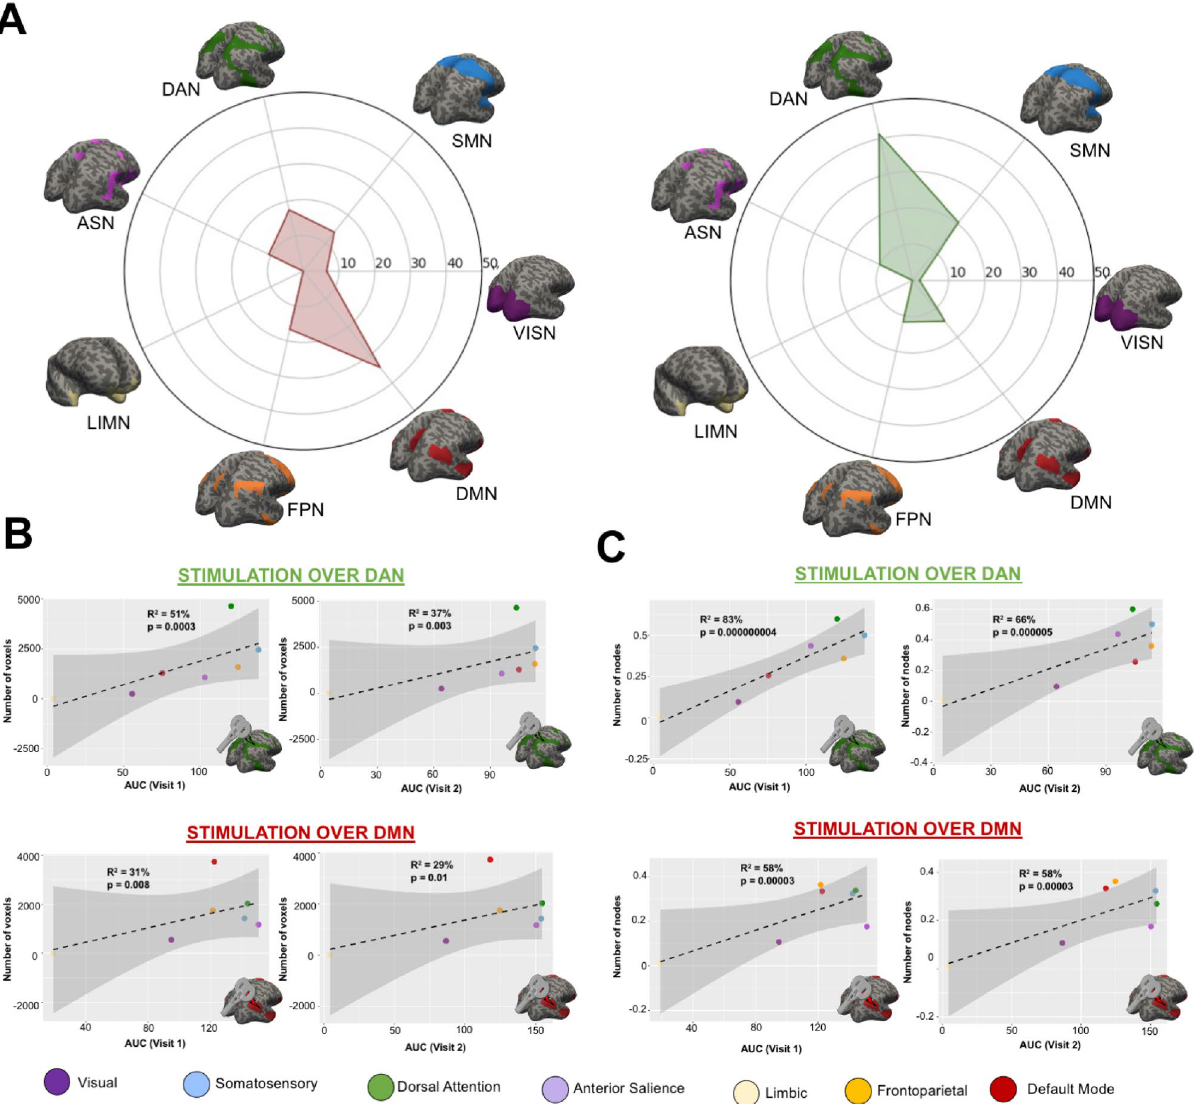
Figure 4. Relationship between source TMS-EEG signal and DWI pathway projection. ( A ) Percentage of grey matter voxels (divided by network) reached by seed-based tractography from the stimulation spot. As for angular gyrus (DMN stimulation seed), the white matter fibers not only reach cortical regions belonging to the DMN (34.52%) but also affect the other RSNs (VISN = 6.52%; SMN = 13.95%; DAN = 17.55%; ASN = 10.72%; LIMN = 0.04%; FPN = 16.71%). Likewise for the superior parietal lobule (DAN stimulation spot), the seed-based tractography do not involve grey matter voxels belonging to DAN (41.38%), but also reach the other RSNs (VISN = 2.00%; SMN = 20.42%; ASN = 9.98%; LIMN = 0.01%; FPN = 11.77%; DMN = 14.45%). ( B ) A significant positive correlation was found between the number of voxels reached by the seed-based tractography (divided by network) and the AUC extracted for both DAN (visit 1: R 2 = 51%, p = 0.0003; visit 2: R 2 = 37%, p = 0.003) and DMN (visit 1: R 2 = 31%, p = 0.008; visit 2: R 2 = 29%, p = 0.01). ( C ) A significant positive correlation was found between the number of networks nodes (normalized for the overall number of network nodes) reached by the seed-based tractography and the AUC extracted for both DAN (visit 1: R 2 = 82%, p = 0.000000004; visit 2: R 2 = 66%, p = 0.000005) and DMN (visit 1: R 2 = 58%, p = 0.00003; visit 2: R 2 = 58%, p = 0.00003). Scatterplots were generated using R software (https:// www.R- proje ct. org/) 44 version